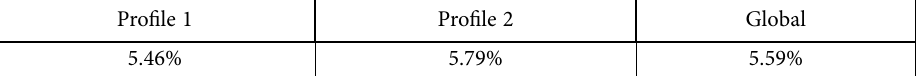
Table 3. Lack of liquidity for a family. Probability (%) without RM (source: own elaboration) Profile 1 Profile 2 Global 5.46% 5.79% 5.59%